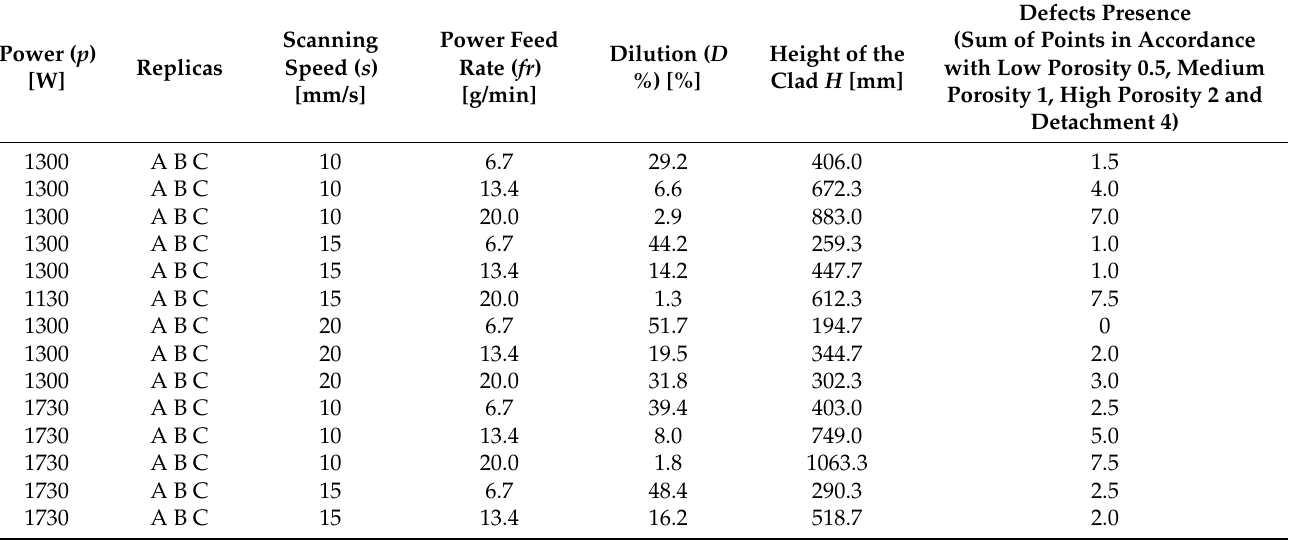
Table 2. Results of preliminary investigations.